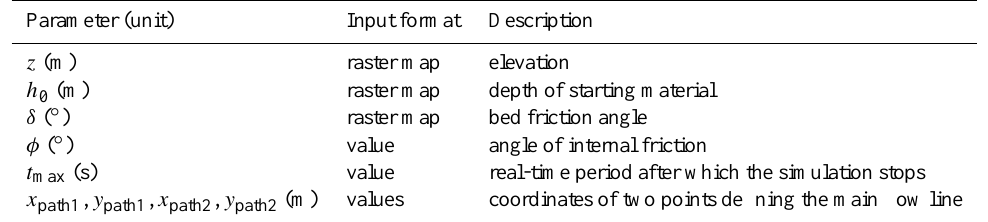
Table 2. Input parameters for r.avalanche . Parameter (unit) Input format Description raster map raster map depth of starting material raster map bed friction angle value angle of internal friction value real-time period after which the simulation stops values coordinates of two points defining the main flow